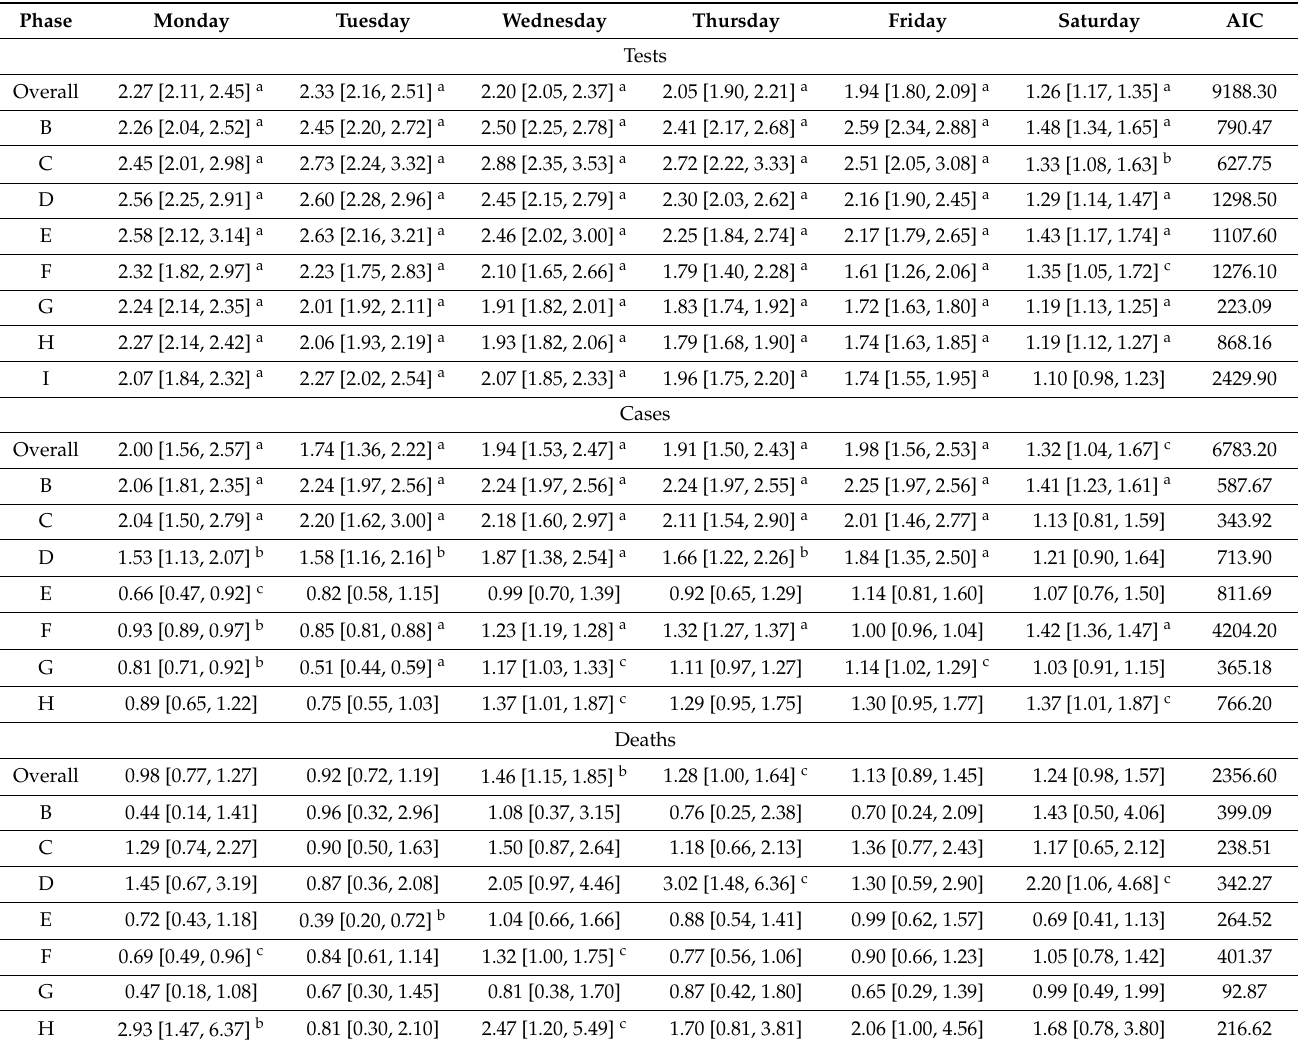
Table 5. Rate ratios (with 95% confidence intervals) of DoW effects relative to Sunday for the full study period (Overall) and by public health policy intervention phase from 2 March 2020 through 7 November 2021. We examined DoW effects using segmented negative binomial regression models adjusted for log-link functions. We adjusted each model with linear and quadratic trends for the outbreak signature critical periods occurring within each intervention phase. We supplement model findings with Akaike’s Information Criterion (AIC) values used to assess model fit. We report results beginning in Phase B, as this marks the first complete phase aligning with our study period. We exclude Phase I for cases and deaths, as no weekend reporting occurred during this